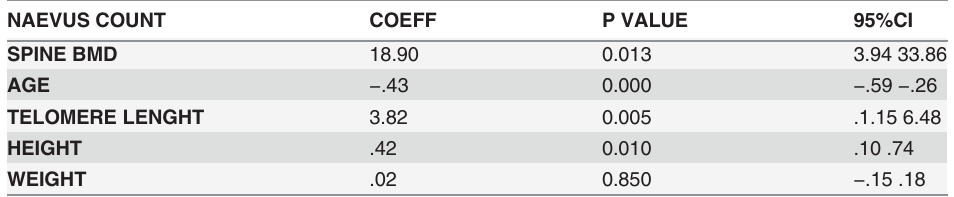
Table 2. Multivariate Linear Regression for the association between naevus count and spine BMD. (Robust regression) (n =